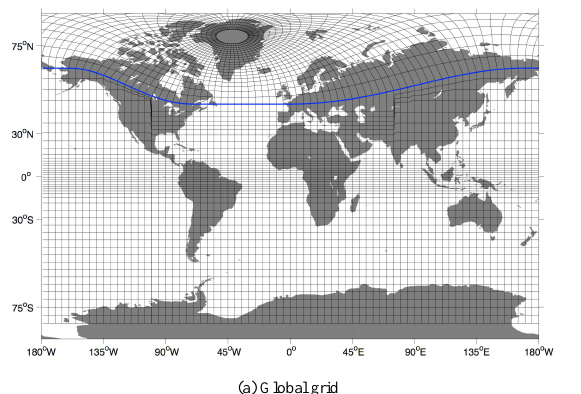
Figure 7. Sample grid with nominal 1 ◦